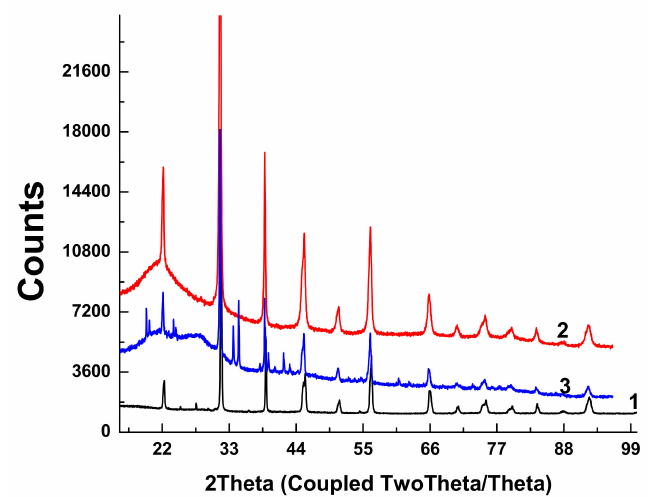
Figure 5. X-ray di ff ractograms of the initial target pellet (1), BTO NPs generated by ablation in H 2 O with 1 ps pulses (2), and BTO NPs generated by ablation in H 2 O with 200 ns pulses (3). Additional di ff raction peaks in the range 20–30 ◦ are due to the